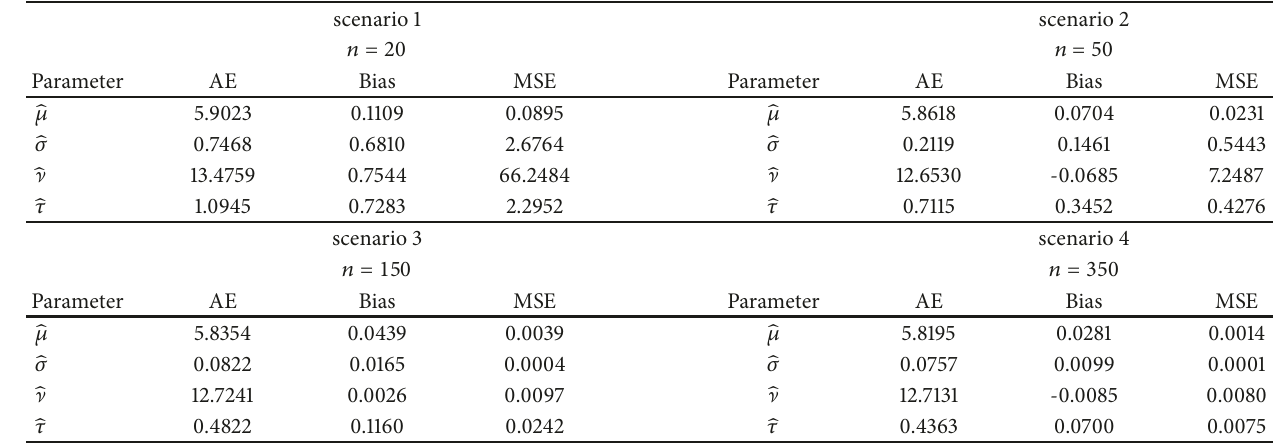
Table 1: AEs, biases, and MSEs for the parameters of the OLLGIG distribution.